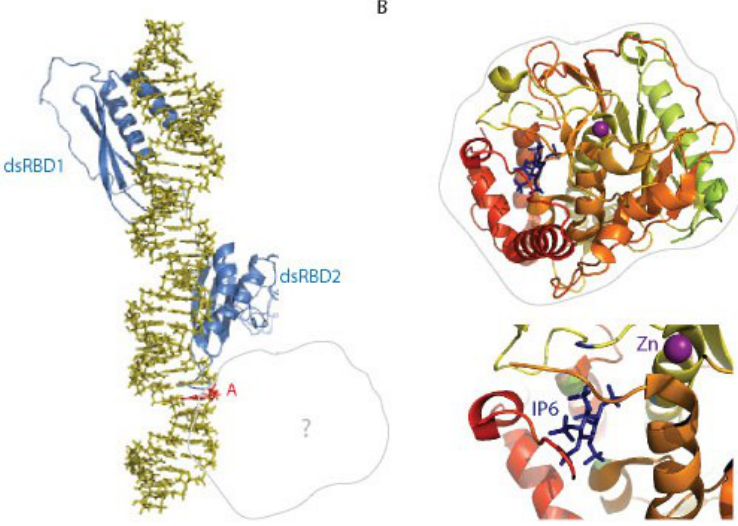
Figure 2. Structural information of ADAR enzymes. ( A ) NMR structure of the dsRBD1 and dsRBD2 of hADAR2 (blue) in complex with the RG stem loop RNA target [37]. The specific adenosine that is deaminated in the catalytic reaction is highlighted in red. In grey is shown where the deaminase domain is likely positioning during the reaction. PDB file: